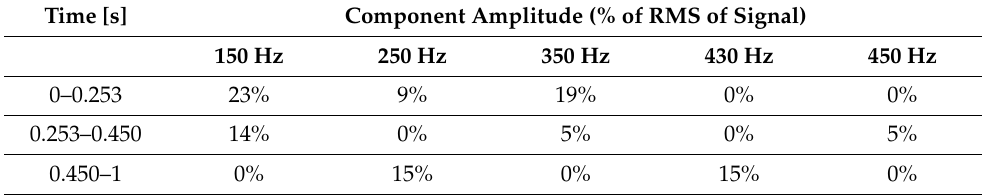
Table 1. Components of the original signal under investigation.